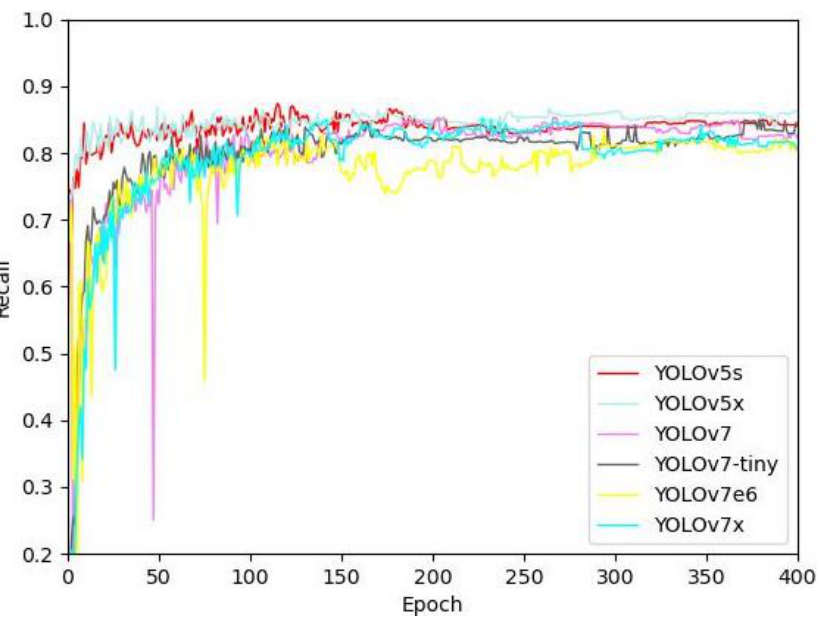
Figure 6. Comparison of training recall.